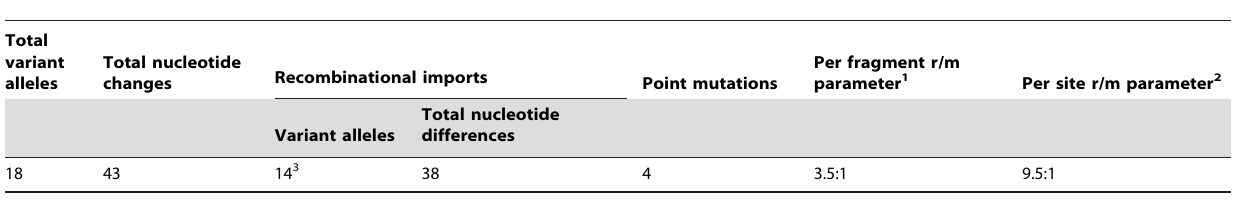
Table 6. Relative contributions of recombination and mutation to recent clonal divergence.